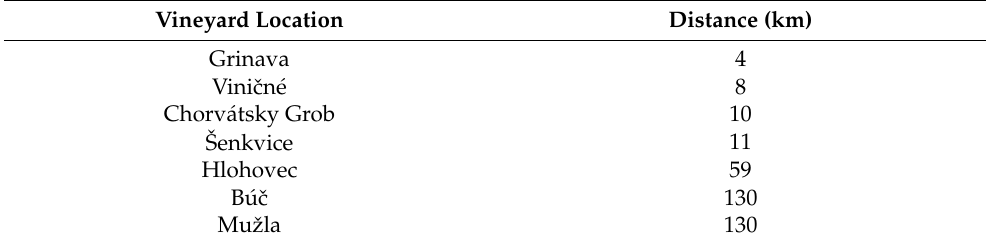
Table 1. Distance of grape suppliers from the central warehouse. Vineyard Location Distance (km)